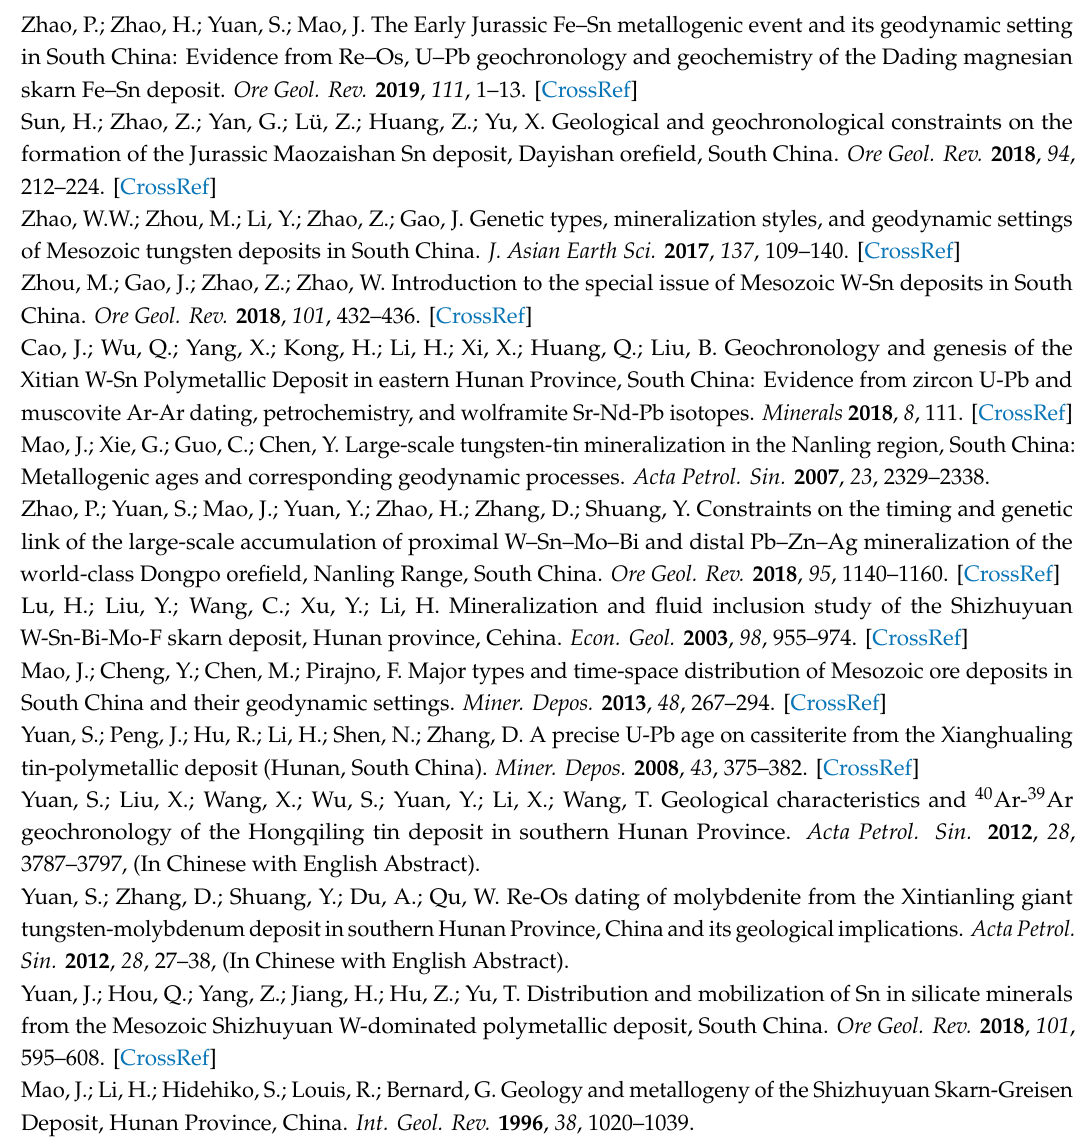
Table S1: LA-ICP-MS analytical results for silicate minerals and scheelite from the Shizhuyuan